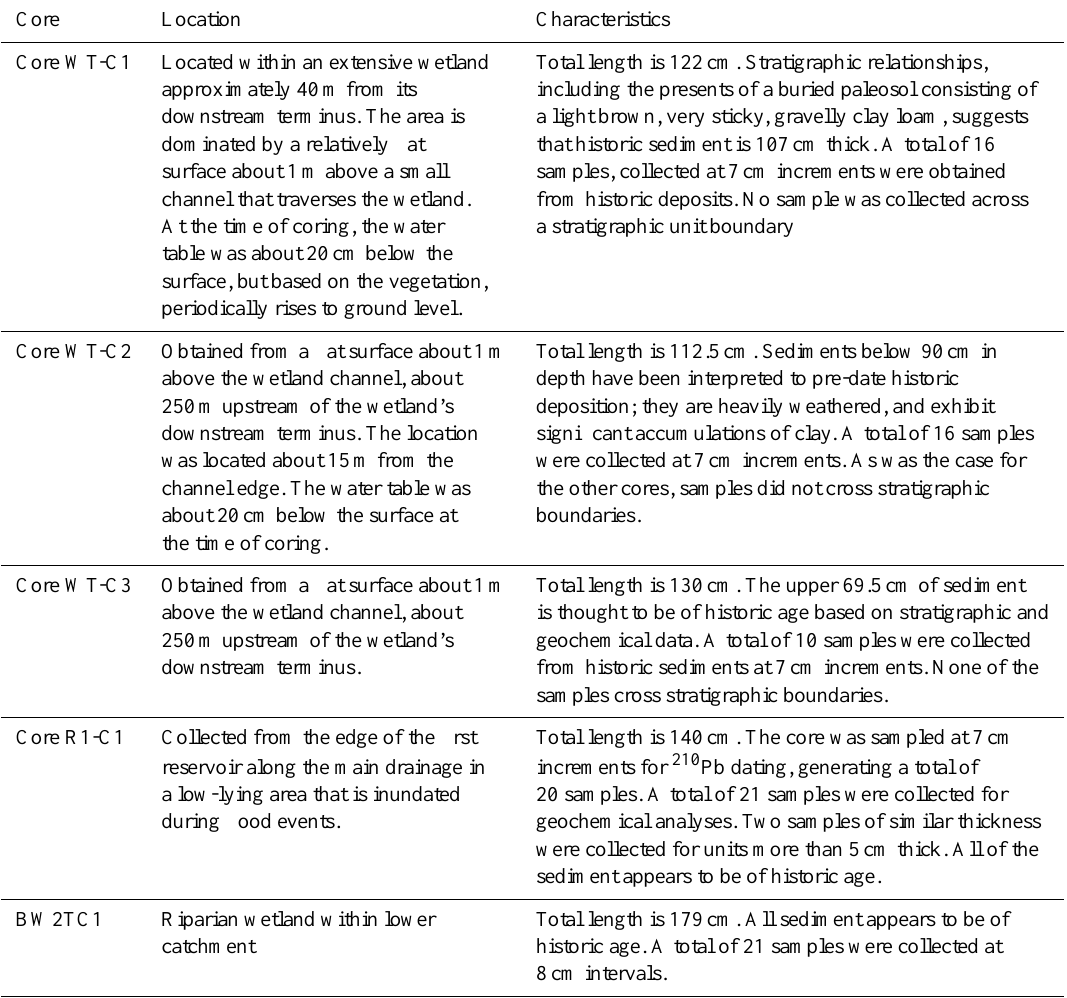
Table 5. Summary of collected